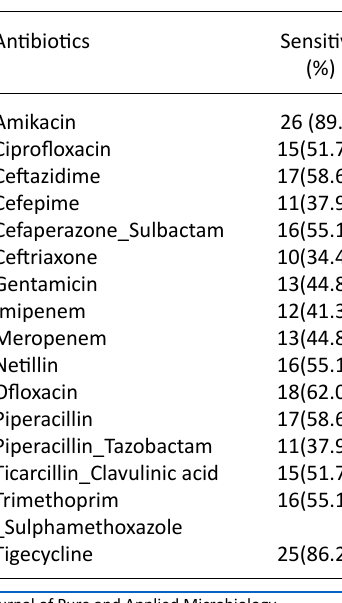
Table 2. The antibiotic sensitivity pattern of Acinetobacter spp. isolated from blood of patients with symptoms of